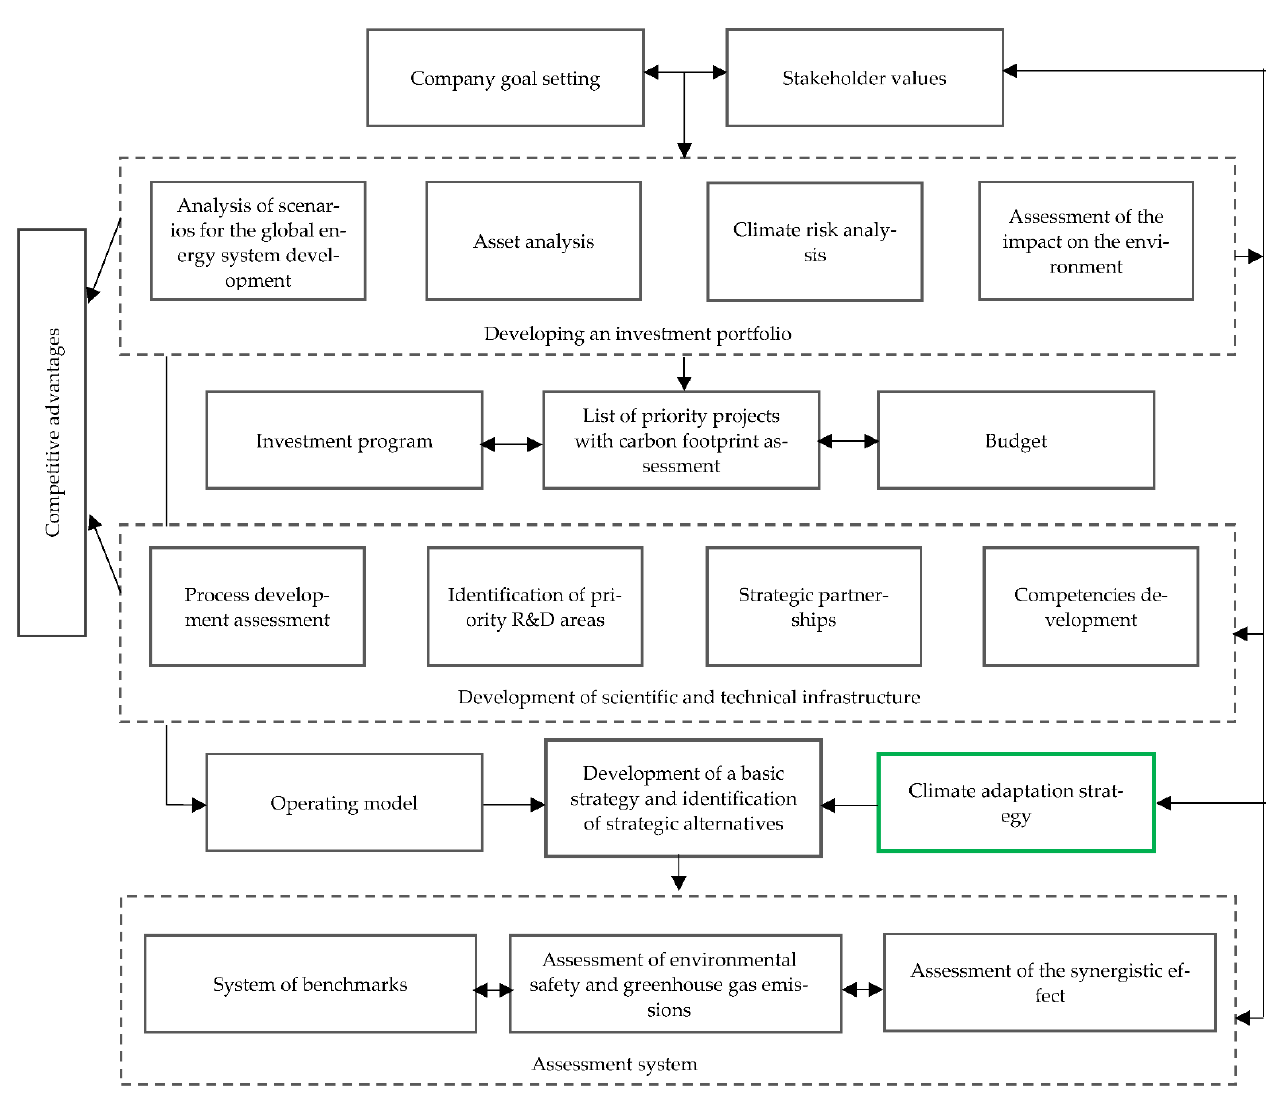
Figure 6. Strategic planning model for an oil and gas company. Source: Created by the authors.